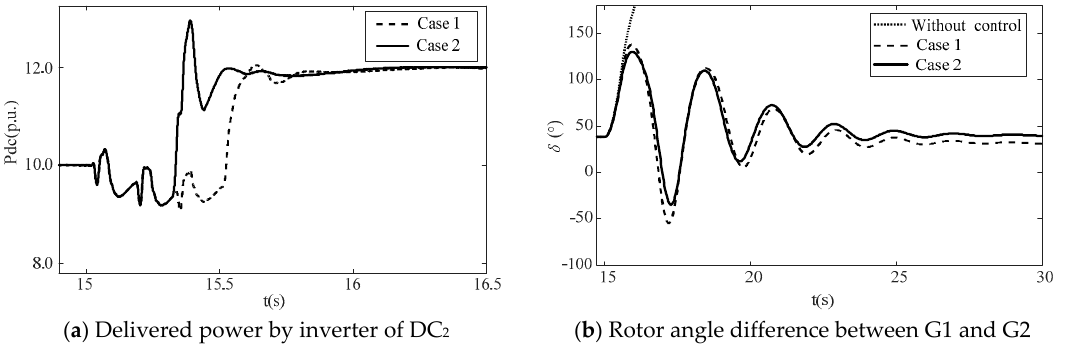
Figure 11. Control effect under different control method.